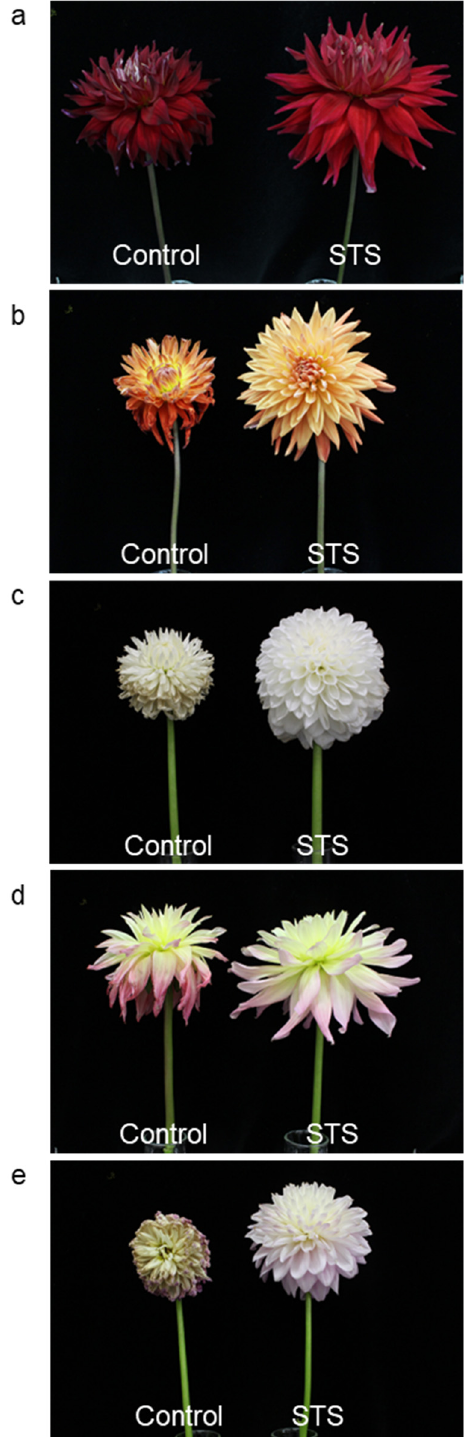
Figure 6. The effect of pulse treatment with STS on the vase life of cut dahlia. ( a ) ‘Agitate’ on day 3; ( b ) ‘Carnelian’ on day 4; ( c ) ‘Kamakura’ on day 5; ( d ) ‘Moon Waltz’ on day 5; ( e ) ‘Namahage Cute’ on day 7.